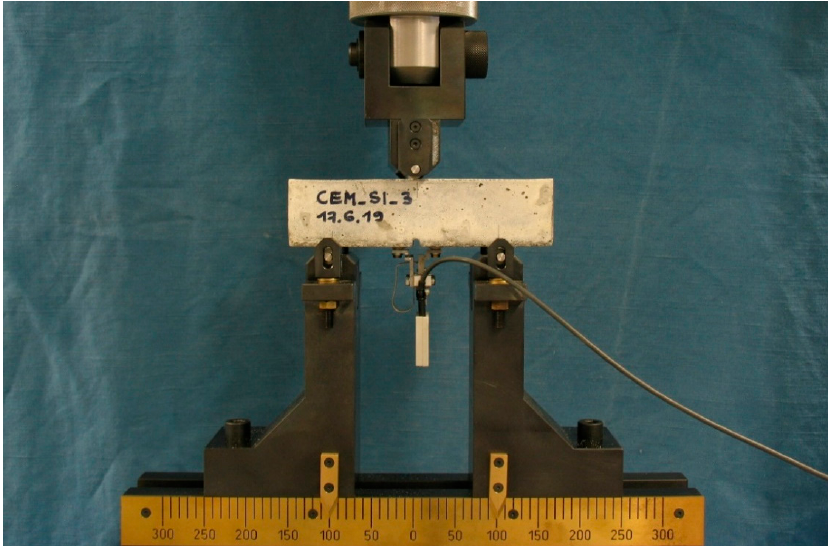
Figure 5. Setup of the pre-cracking procedure.